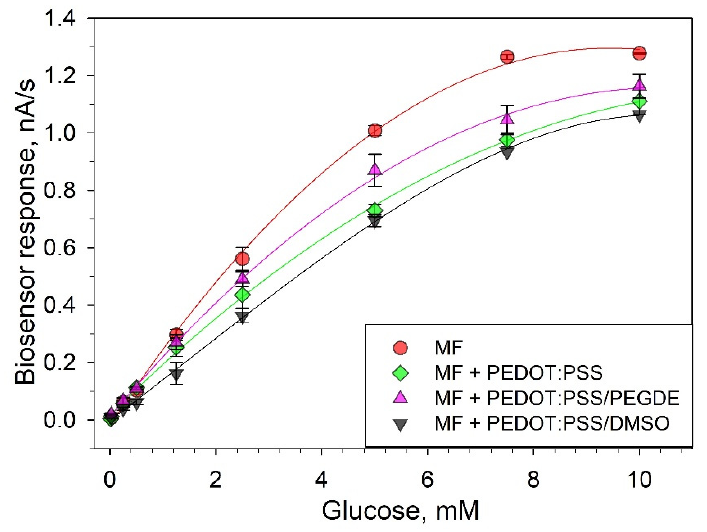
Figure 3. Respiratory activity of membrane fractions in the presence and absence of PEDOT:PSS gels.